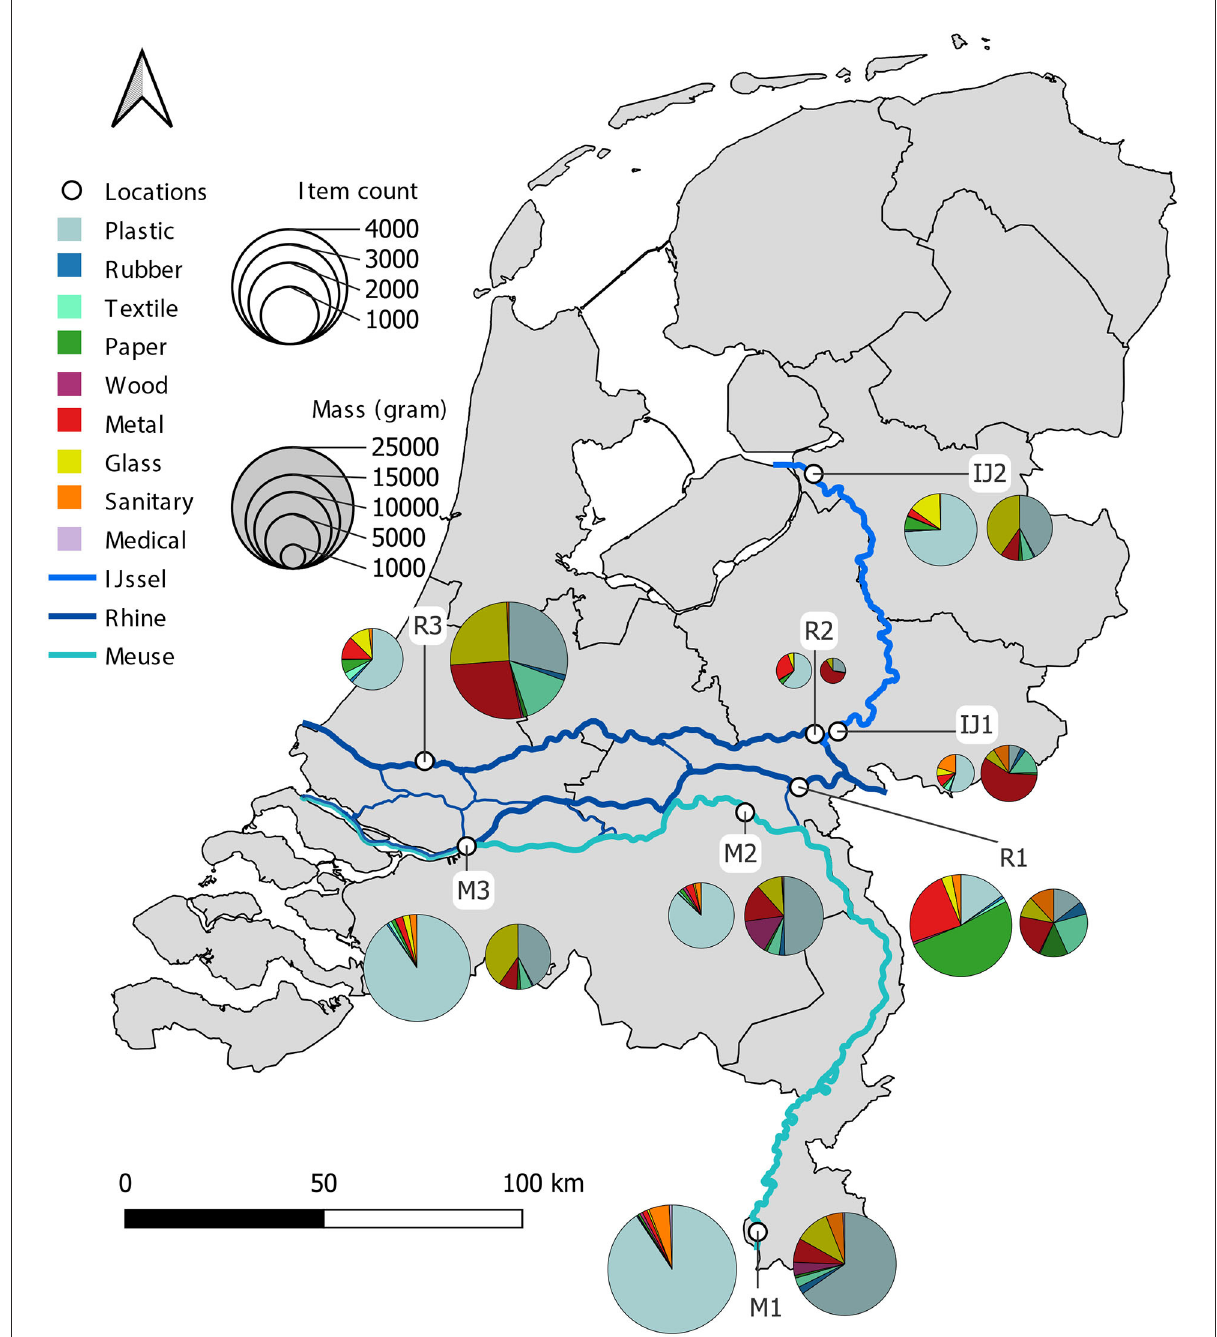
FIGURE2 Map showing the eight riverbank locations along the Dutch Rhine (R1, R2, and R3), Meuse (M1 and M2), and IJssel (IJ1 and IJ2) rivers. For each location, the total number of litter items (left pie chart) and the total mass of litter items (right pie chart) found for the nine parent litter categories (plastic, rubber, textile, paper, wood, metal, glass, sanitary, and medical) is shown. The diameters of the pie charts indicate the total amount and mass of the items.